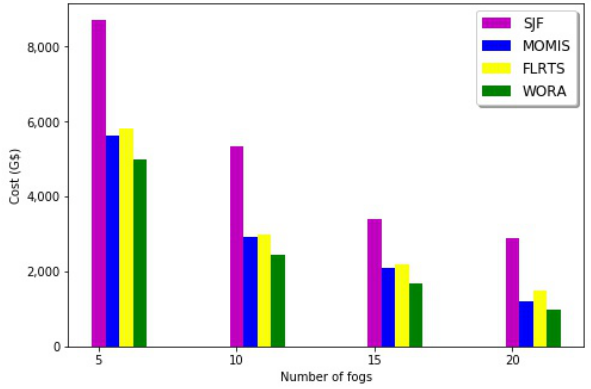
Figure 7. Computation of cost for fog with 500 tasks.